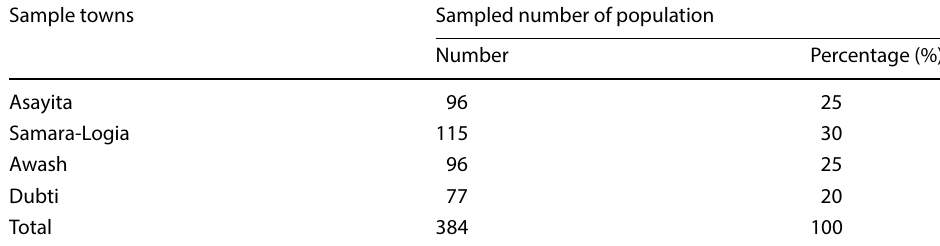
Table 1 Proportion of sample households from each town of Afar regional state,